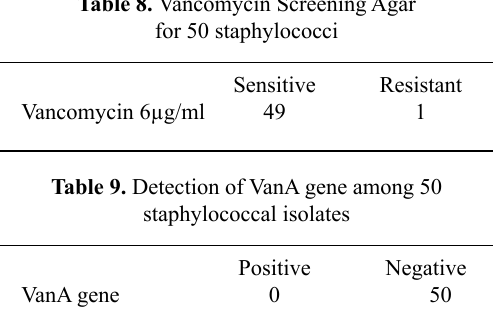
table 8. Vancomycin Screening Agar